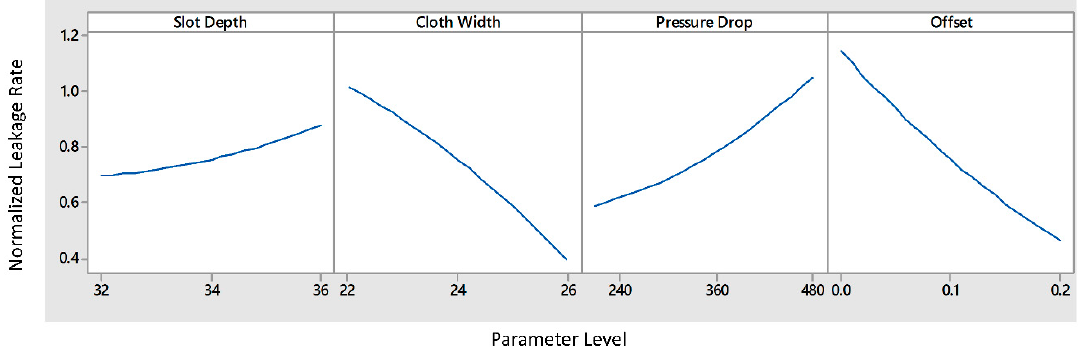
ff ect plots for normalized leakage rate (main Figure 15. The effect plots for normalized leakage rate (main experiments). Figure 15. The e